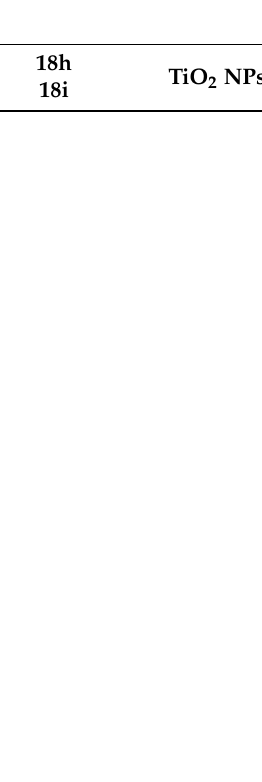
Table 9. Effect of light fastness and UPF on ZnO or TiO 2 NPs treated polyester fabrics. Dye